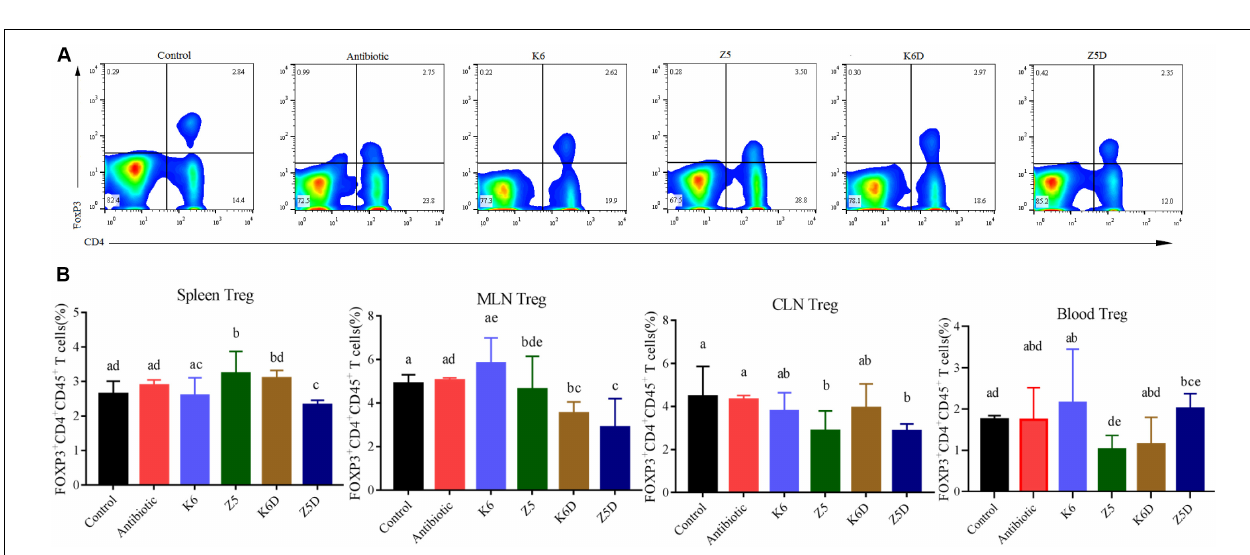
FIGURE 5 | Th1 cell induction and its role in DSS-induced colitis in mice model. (A) Data represent flow plots and quantification of Th1 cell portion of spleen. (B) In the spleen, MLN, CLN, and blood in each group. Different letters indicate significant differences ( P < 0.05, one-way ANOVA) between different groups (mean ± SD, n = 3–7 mice per group).